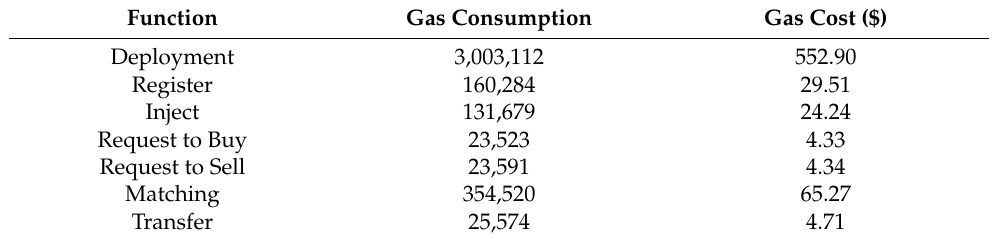
Table 8. Gas consumption for the functions in our system assuming the public Ethereum network.